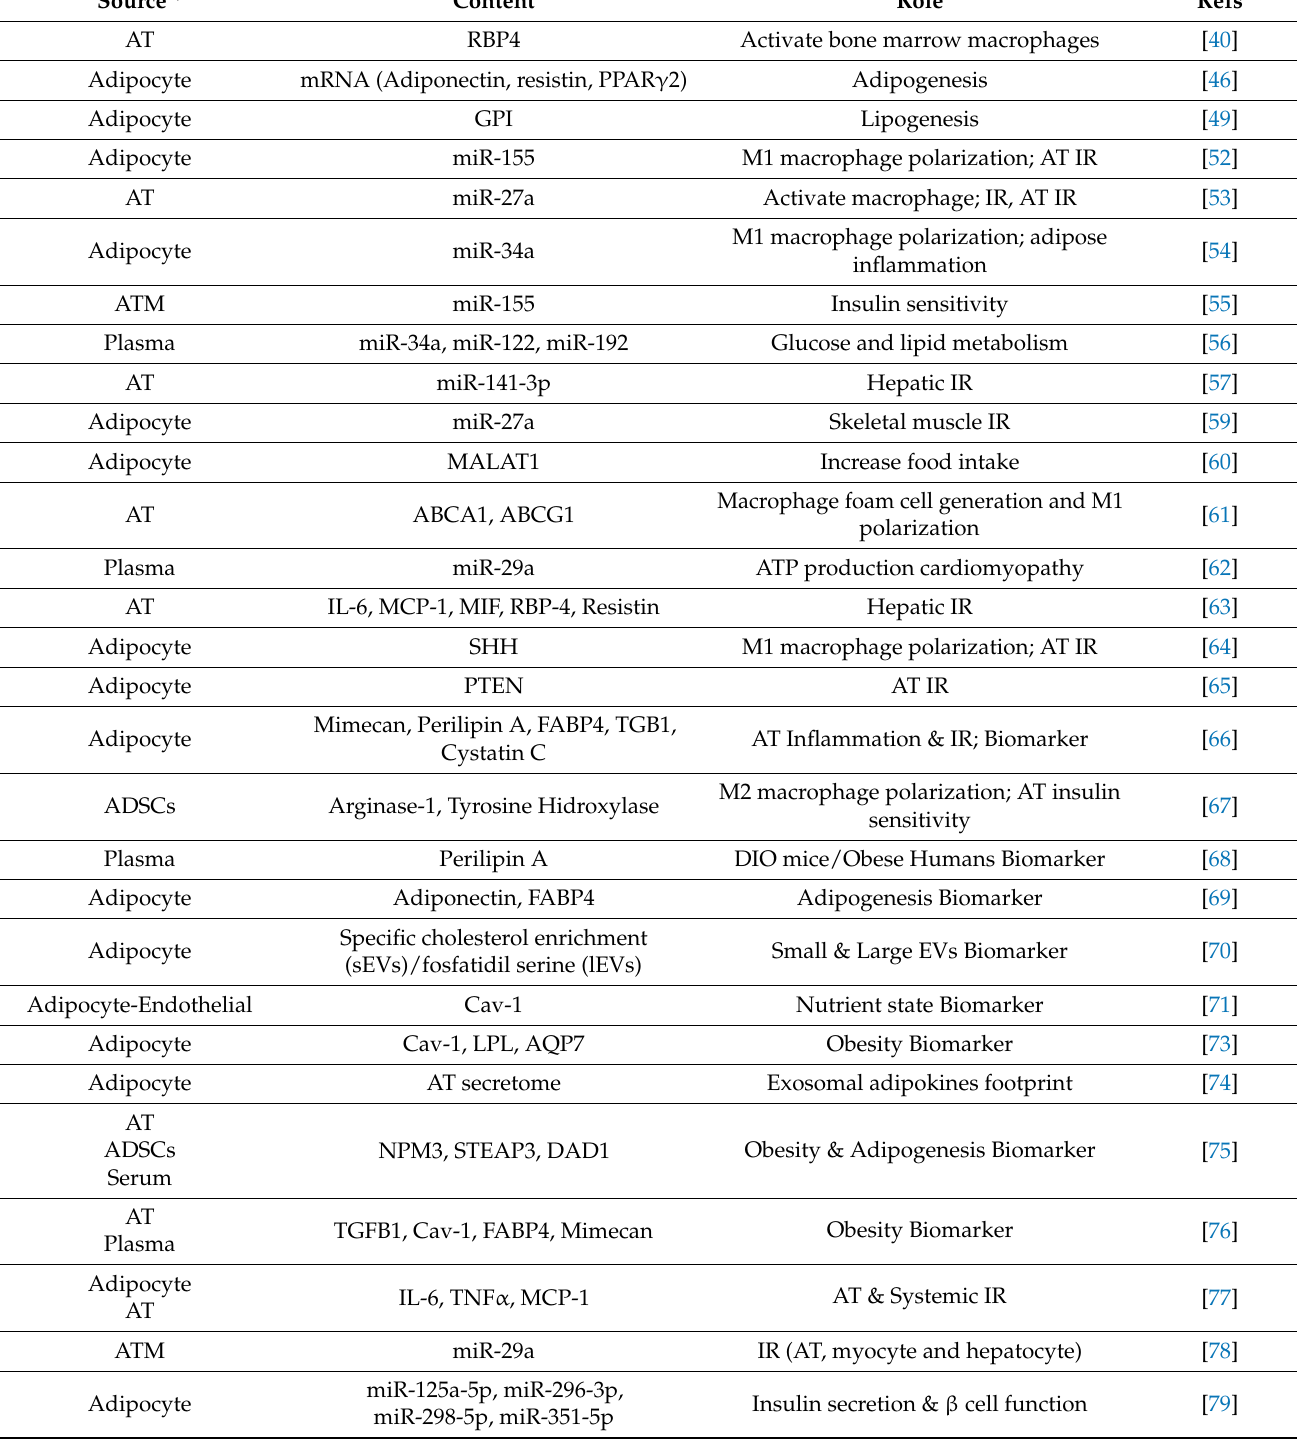
Table 1. Adipose tissue-derived extracellular vesicles and their metabolic